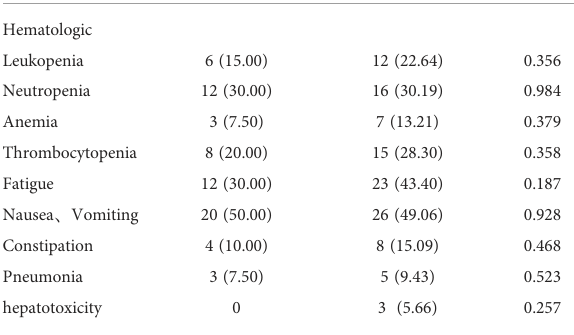
TABLE 3 Grade 3 & 4 CTC that occurred during adjuvant course of